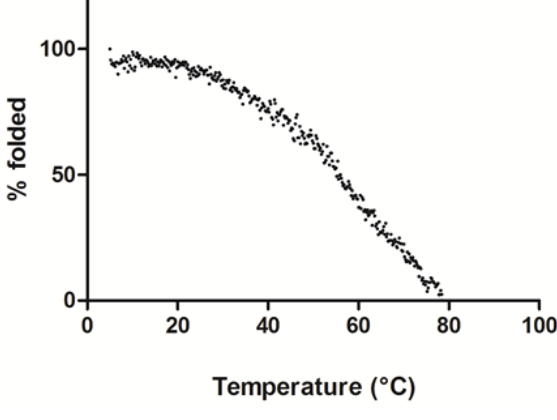
Figure 5. Thermal transition curves for 5FAM ellipticity ( Θ = 225 nm) while the temperature was